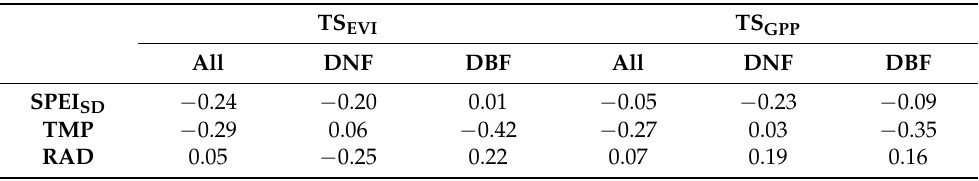
Table A1. Partial correlation coefficients of SPEI SD , temperature and radiation with TS EVI and TS GPP . In this study, the p values of all results were less than